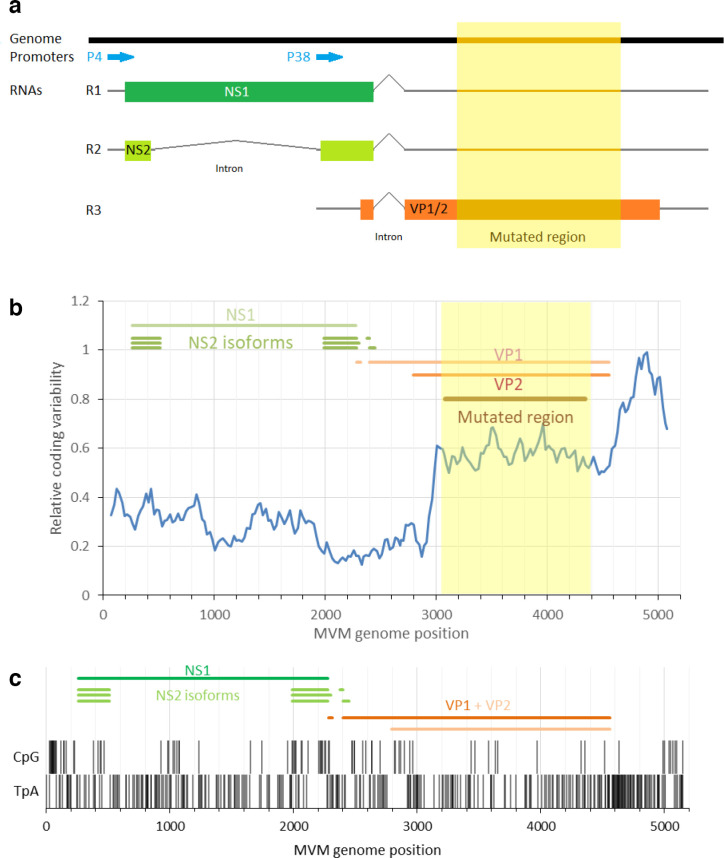
MVM genomic structure and the capsid gene region selected for mutagenesis. (a) Diagram of the MVM genomic structure. Promoters (blue), transcripts (r1-r3) with ORFs (green and orange coloured boxes), mutated region highlighted in yellow. Based on, Fig. 57.10 of Berns and Parrish [65]. (b) SSE was used to calculate the synonymous coding variability observed between MVM and related parvoviruses. The orange region indicates the region chosen for mutations. (c) Distribution of CpGs and TpAs in the MVM genome.